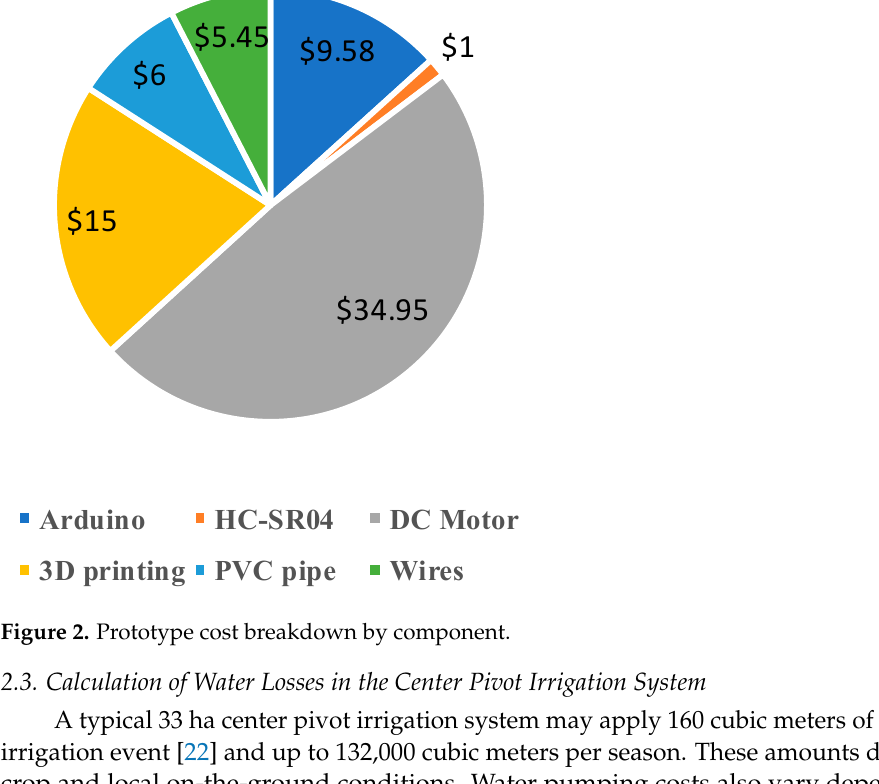
Table 2. Irrigation water lost by wind draft during an irrigation event from the center pivot irrigation